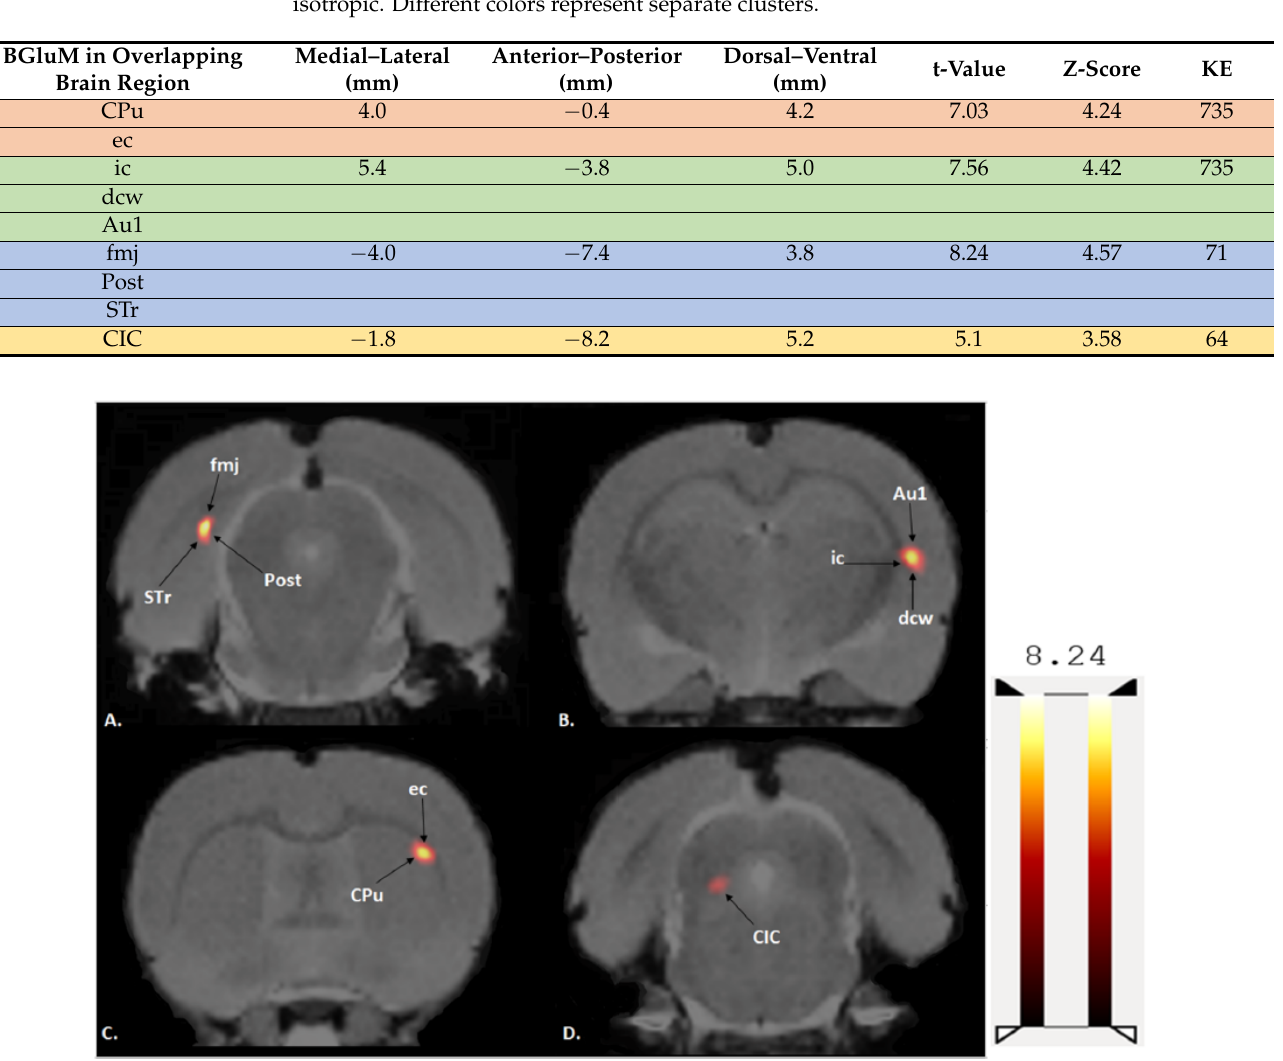
Table 1. Brain regions where there was a significant brain glucose metabolism (BGluM) activation effect between exercised and sedentary rats at ( p < 0.001, df = 11) voxel threshold K > 50. Coordinates in stereotaxic space (medial–lateral, anterior–posterior, and dorsal–ventral) are provided for cluster location. The t-values and z-scores were calculated from the average BGluM of all voxels within the significant clusters. The number of voxels in the significant clusters is noted “KE”, voxel size 0.2 mm isotropic. Different colors represent separate clusters.